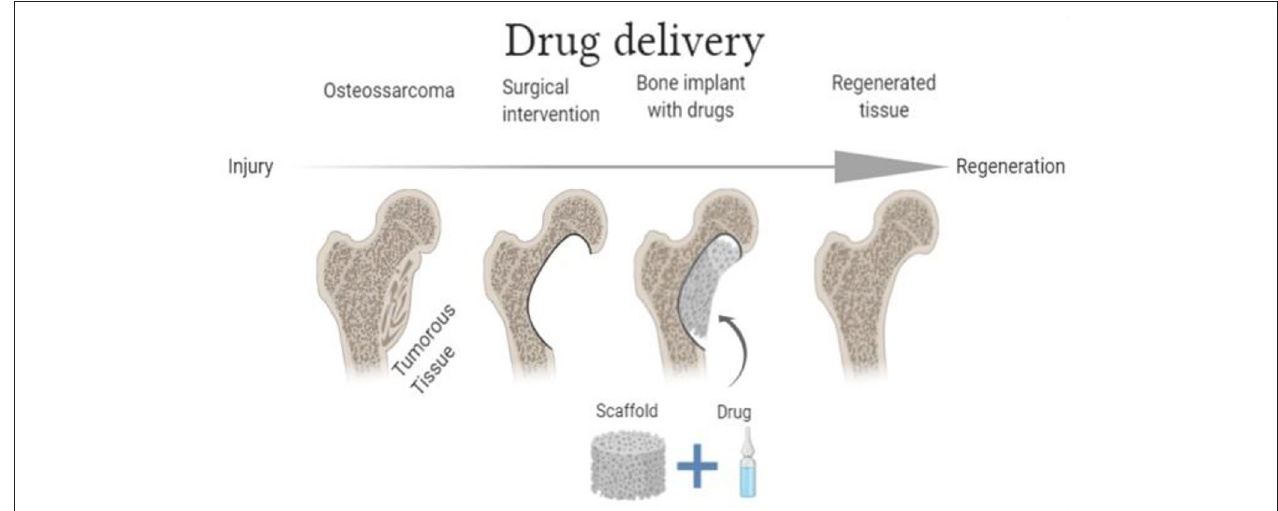
FIGURE 1 | Schematic illustration of the functioning of drug delivery scaffolds (Image Source: created using